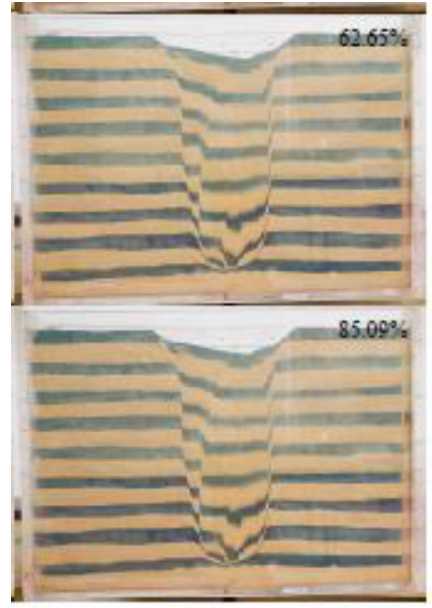
Figure 6. Failure surfaces with compact sand fill, the percent- ages refer to balloon volume reduction (photo taken by Es- merelda